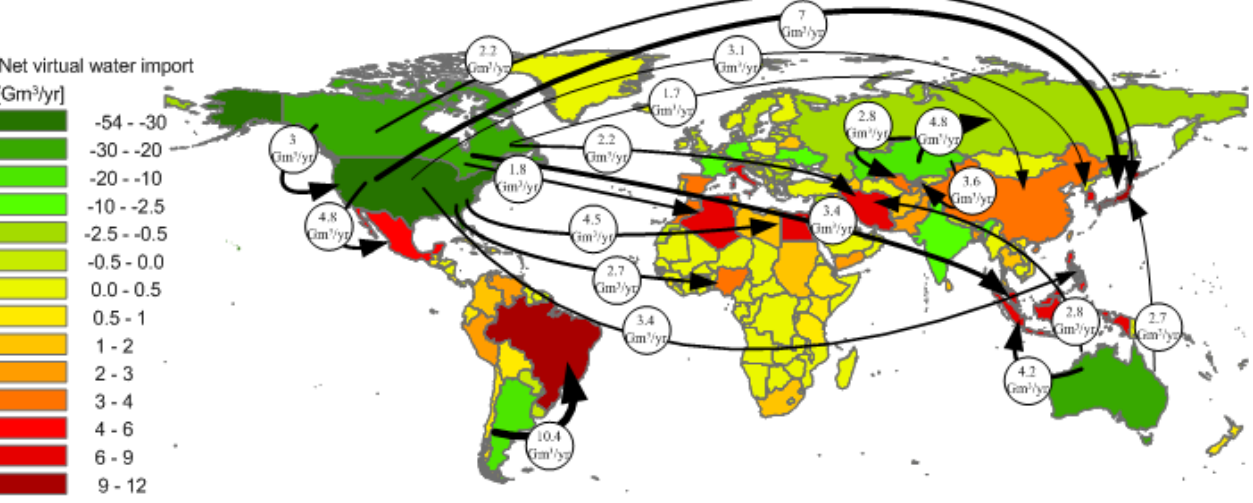
Fig. 2. National virtual water balances and net virtual water flows related to trade in wheat products in the period 1996–2005. Only the largest net flows ( > 2Gm 3 /yr) are shown.